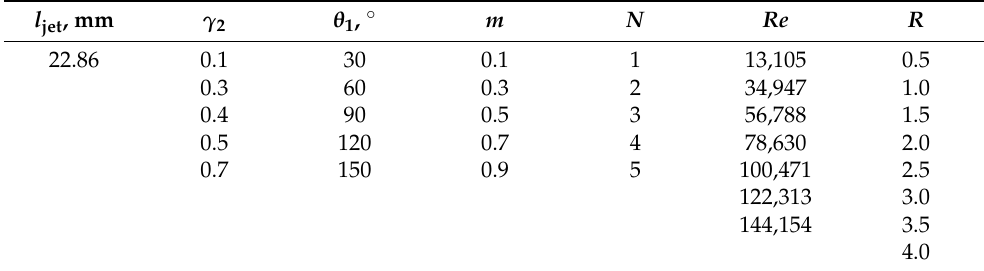
Table 6. Structural parameters and operating conditions on the flow and mixing simulation in VTM.